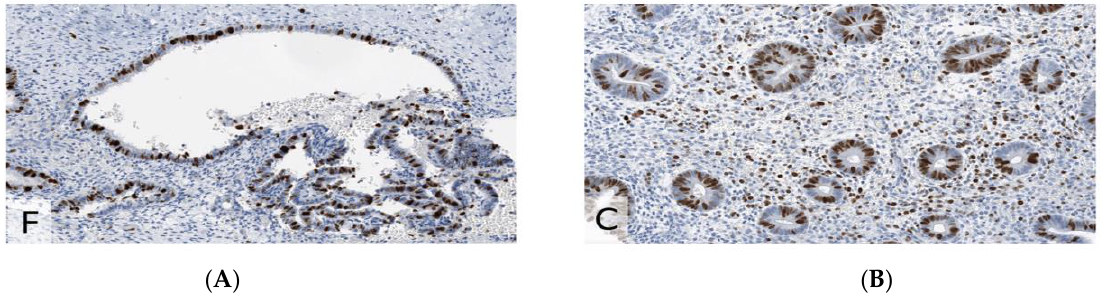
Figure 6. IHC for Ki67 (MiB1), demonstrating the same proliferative index (40%) in endometriosis compared to endometrium (×200). ( A ) Endometriosis. ( B ) Endometrium.